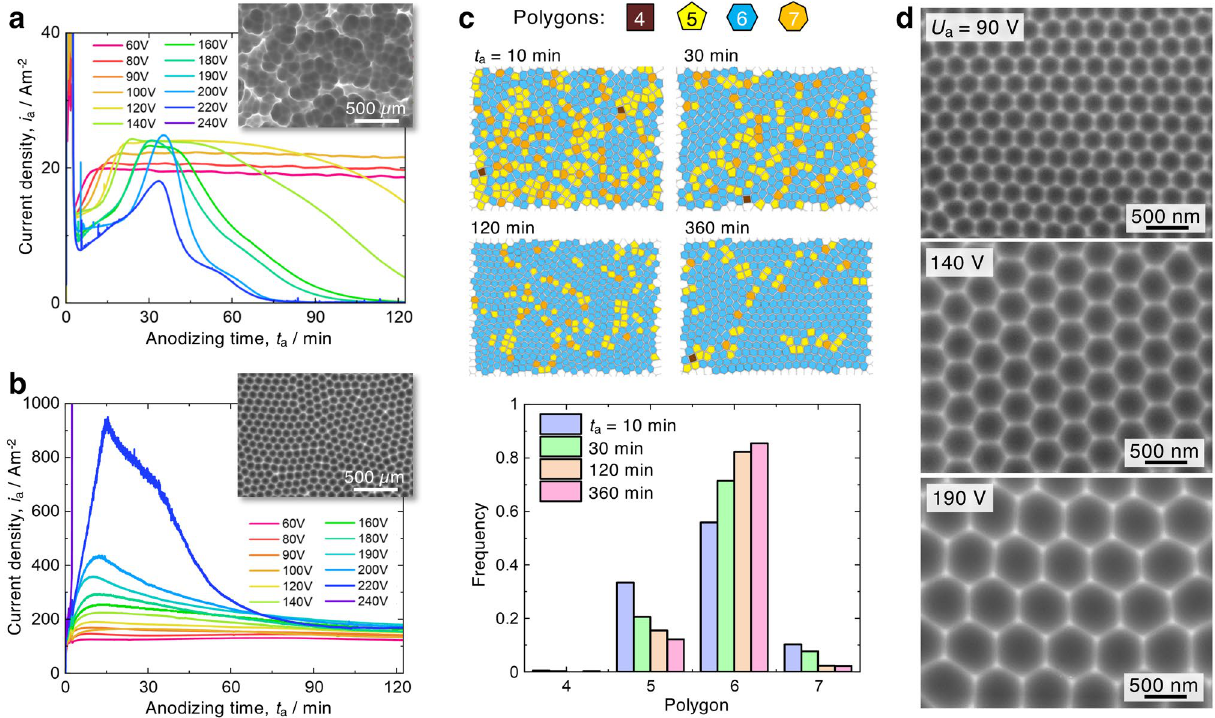
Figure 1. Self-ordering of porous AAO structures fabricated in alkaline Na 2 B 4 O 4 solution. ( a ) and ( b ), Changes in the current density, i a , with the anodizing time, t a , during the potentiostatic anodizing process of Al at various applied voltages ranging from 60–240 V in a 0.5 M sodium tetraborate solution at 335 K (pH = 9.1, a ) and 355 K (pH = 8.8, b ). To evaluate the regularity of the porous structure, SEM images of the growth interface after anodizing at 140 V for 120 min and subsequent oxide removal are shown in each inset. ( c ) Polygonal maps (tetragon: brown, pentagon: yellow, hexagon: light blue, and heptagon: orange) of the AAO cell structure formed by anodizing at 355 K and 140 V for 10 min to 360 min and the corresponding frequencies of polygons for each anodizing time. ( d ) SEM images of the self-ordered cell structure obtained by anodizing for 360 min under the optimal conditions: concentration, 0.5 M; temperature, 355 K; and applied voltage, 90–190